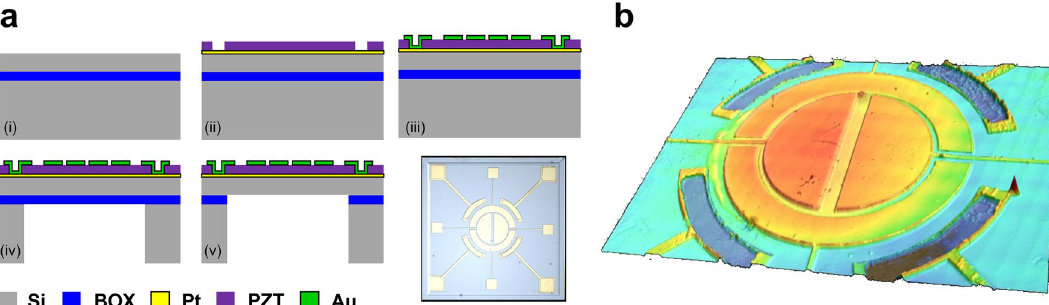
Figure 8. Fabrication process. ( a ) Process flow chart. (i) A 4-inch bare SOI wafer with the stacking layers of active-Si of 2 µm, buried oxide of 0.5 µm, and handle-Si of 400 µm. (ii) First mask: open via to access the bottom electrode (Pt). (iii) Second mask: top and bottom electrodes patterning by a lift-off process. (iv) Third mask: pattern backside cavity. (v) Remove the buried oxide to release the resonator. After finishing the process, the optical image was captured by an optical microscope. ( b ) The 3D profile of the resonator was measured by Keyence laser confocal.